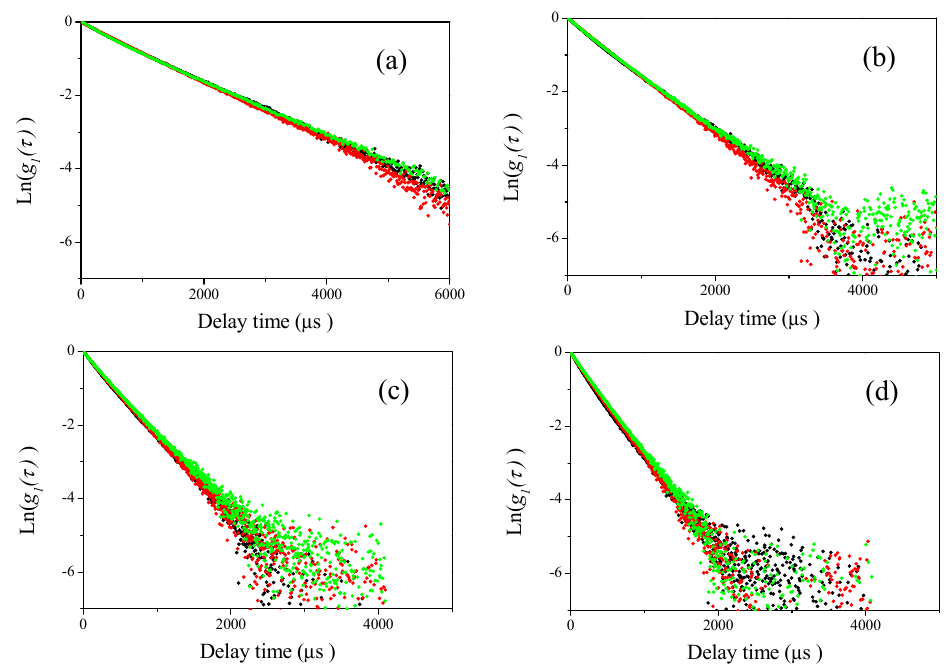
Figure 5. Examples of observed homodyne photon correlation functions for polystyrene latex particles by the DLS method (70-210-1 (black), 70-210-2 (red), and 70-210-3 (green)). ( a ) Light scattering was observed at a detector angle of 60 ◦ ; ( b ) light scattering was observed at a detector angle of 90 ◦ ; ( c ) light scattering was observed at a detector angle of 120 ◦ ; and ( d ) light scattering was observed at a detector angle of 150 ◦